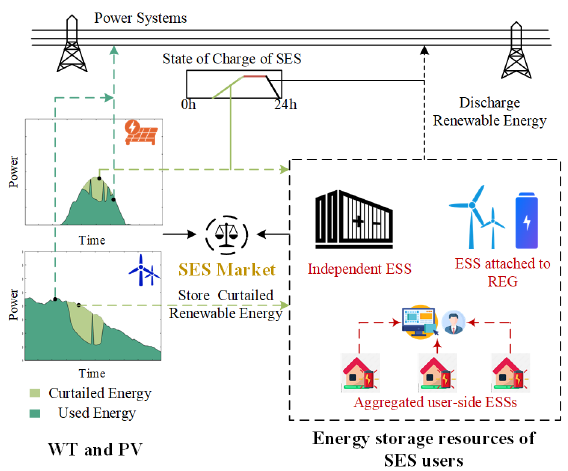
Figure 2. A typical framework of SES in the renewable energy accommodation